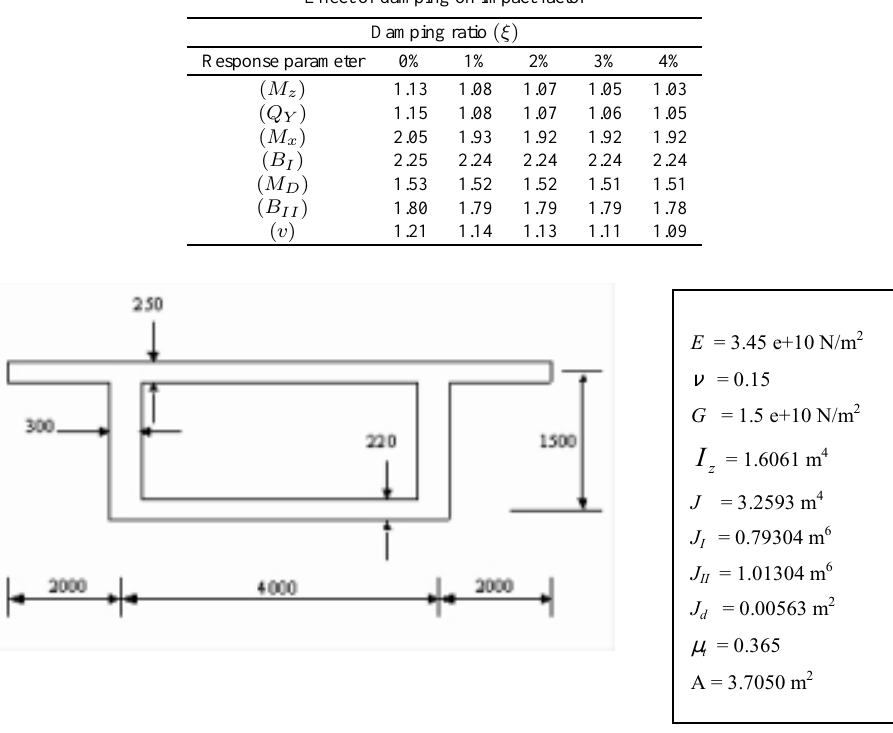
Table 4 Effect of damping on impact factor